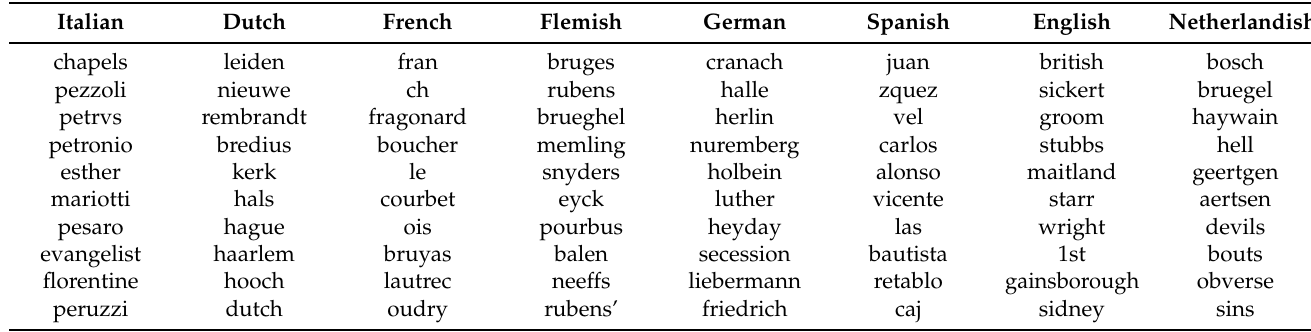
Table 4. Words with highest values for several classes using second-layer construction. We show the top 10 words for each class. (Artists classified by school from comments).